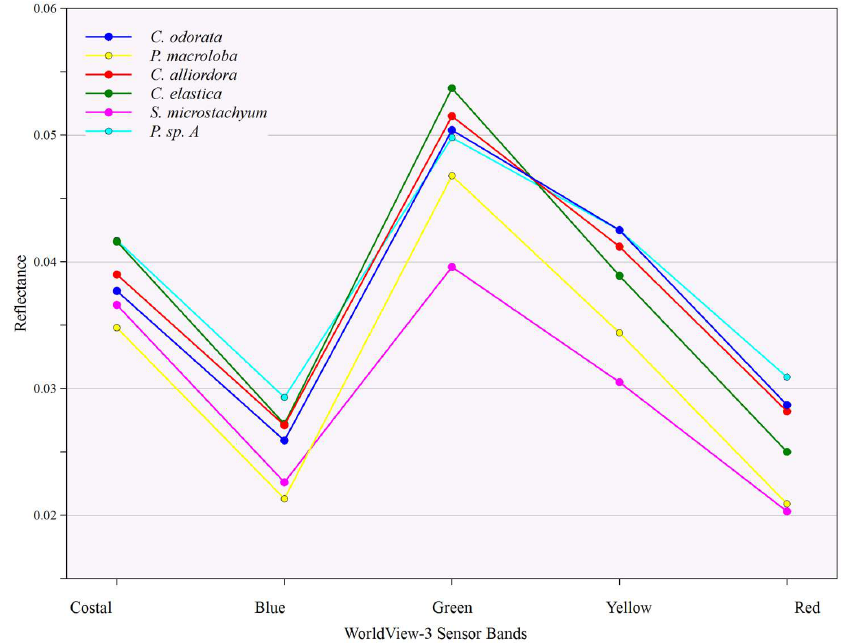
Figure 5. Average WorldView-3 band reflectivity in the visible EM spectrum for the six tree species in this study.